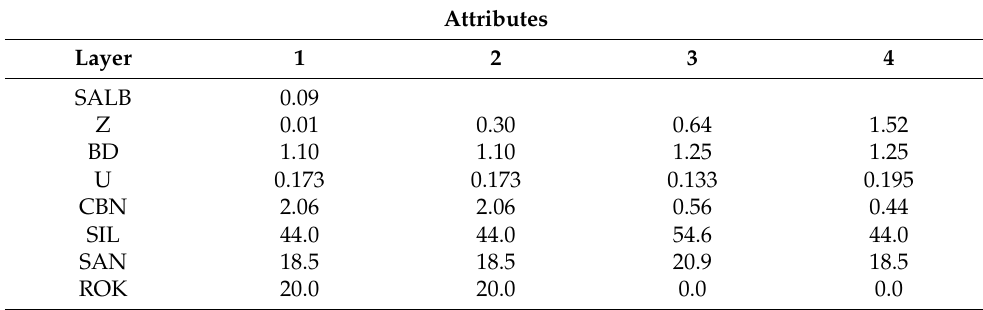
Table 4. Soil parameters used for coffee simulations in Hawai’i. SALB is soil albedo, Z is depth (m), BD is bulk density (Mg/m 3 ), U is wilting point (m/m), CBN is organic carbon (%), SIL is silt content (%), SAN is sand content (%), ROK is coarse fragment content (%).